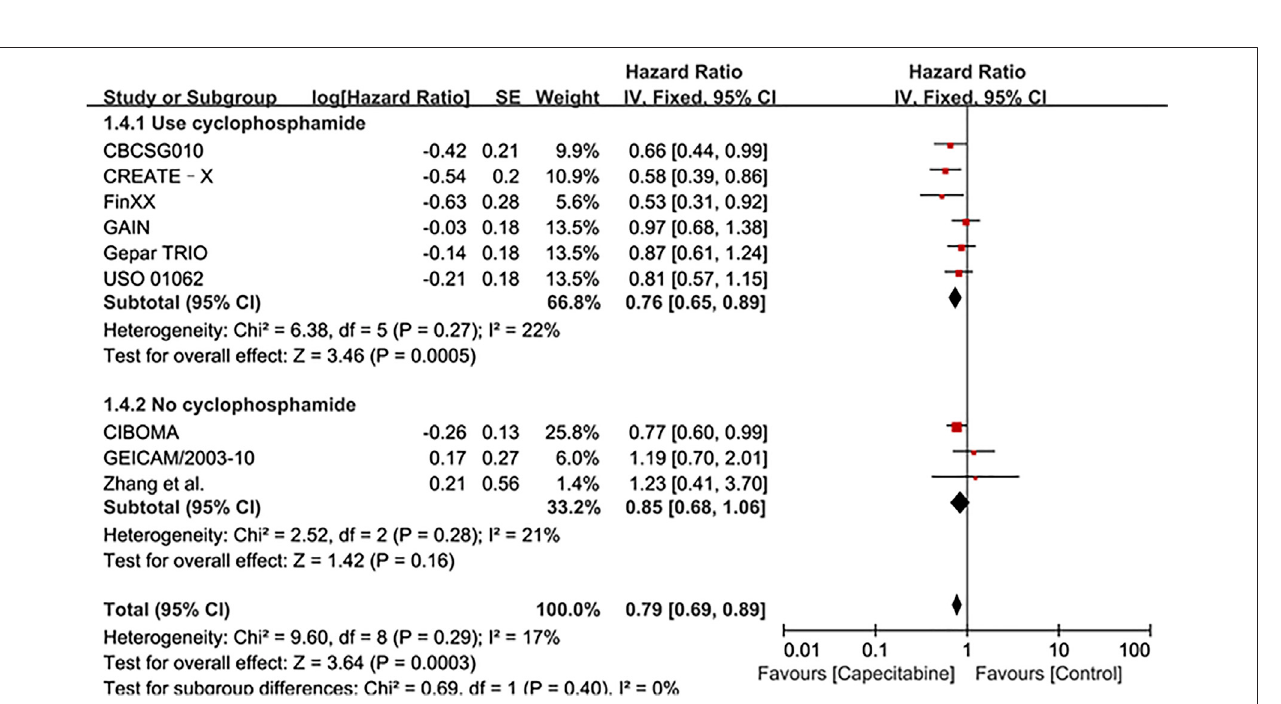
Frontiers in Pharmacology |